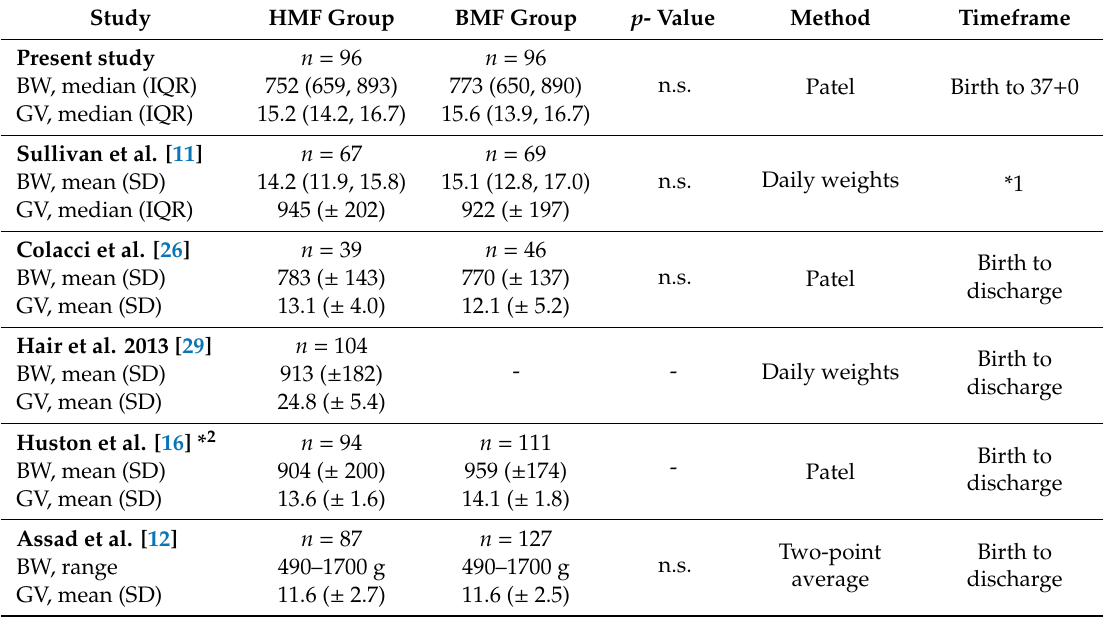
Table 7. Growth velocities (GV)—comparison between data from the present study with the literature. Study HMF Group BMF Group p - Value Method